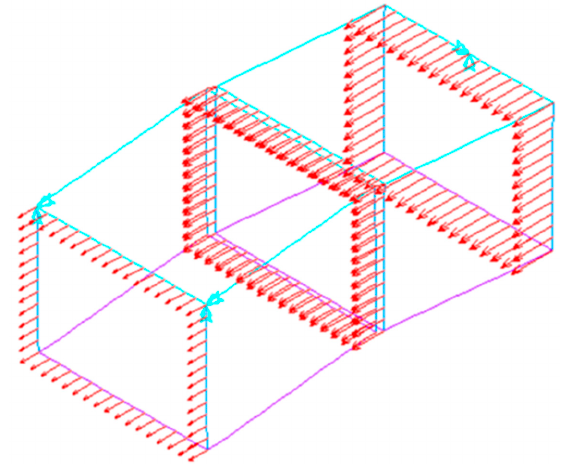
Figure 7. Longitudinal buckling mode of a two cages system applied to distributed current load, in the Holding State. The distributed forces are represented in red and the constraints in light blue arrows.